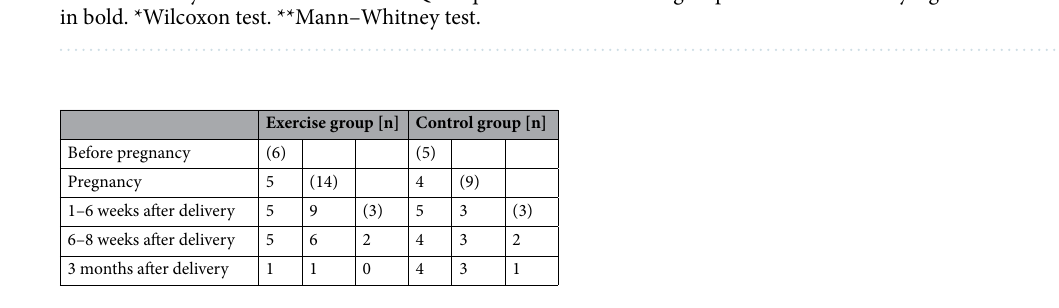
Table 9. Time of onset and incidence of changes in urinary incontinence in subsequent periods of women’s life in both